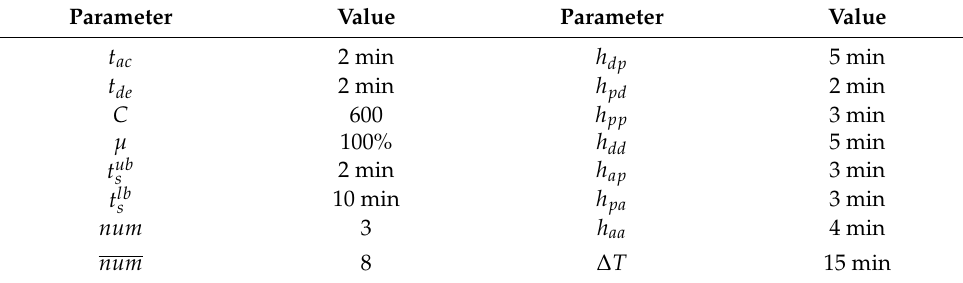
Table 10. Parameters involved in the